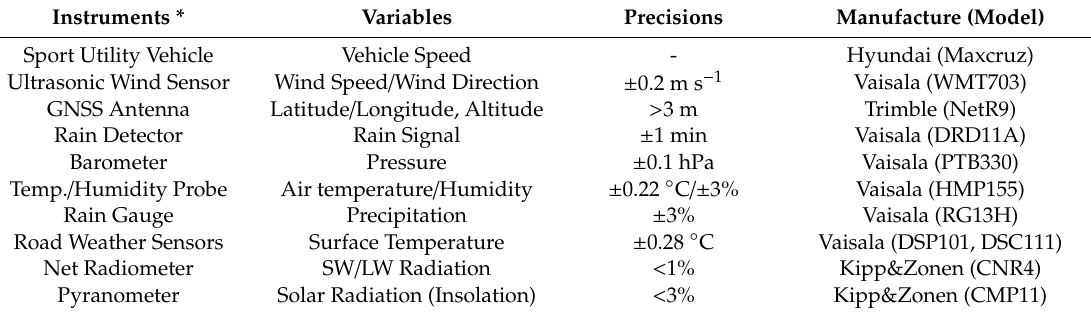
Table 2. Overview of observational instruments from MOVE platform.